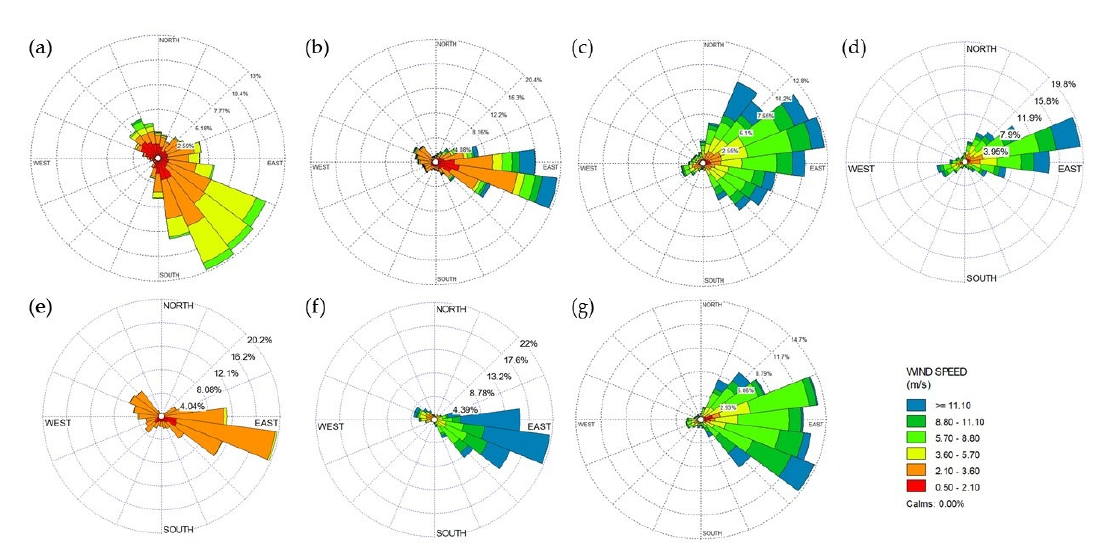
Figure 3. Wind rose plot during the experimental period (January 2019 to January 2020) for studied monitoring sites. ( a ) Cadereyta, ( b ) Escobedo, ( c ) Obispado ( d ) Pastora, ( e ) Pueblo Serena, ( f ) Santa Catarina, and ( g ) Universidad.